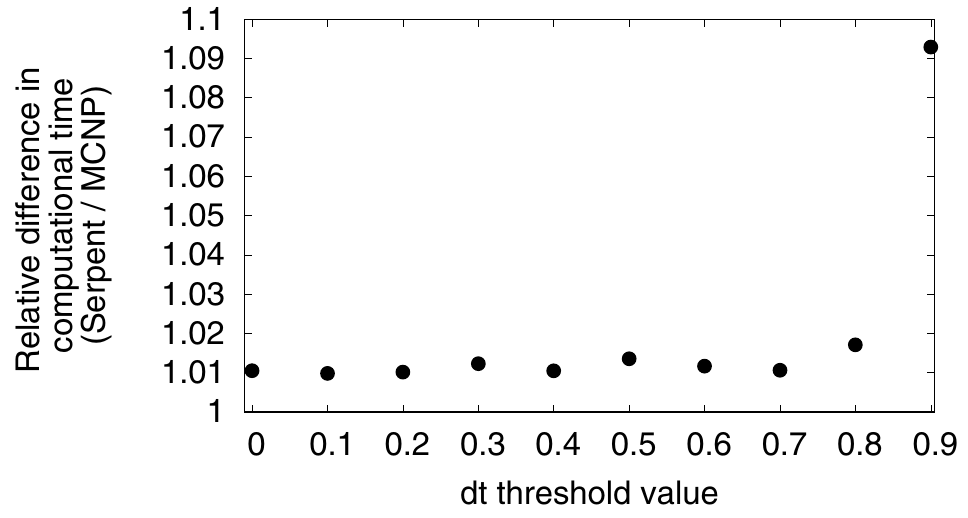
Figure 5: Relative difference in computational time of Serpent to MCNP for different threshold values of parameter dt for determination of used transport method. The results presented are only for a DD plasma but the results are similar for a DT